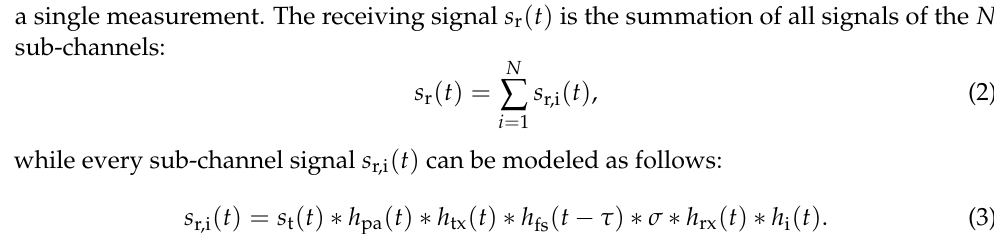
Figure 1. Block diagram of the proposed bi-static radar setup with RX-channel coding single measurement. The receiving signal s r ( t ) is the summation of all signals of the N